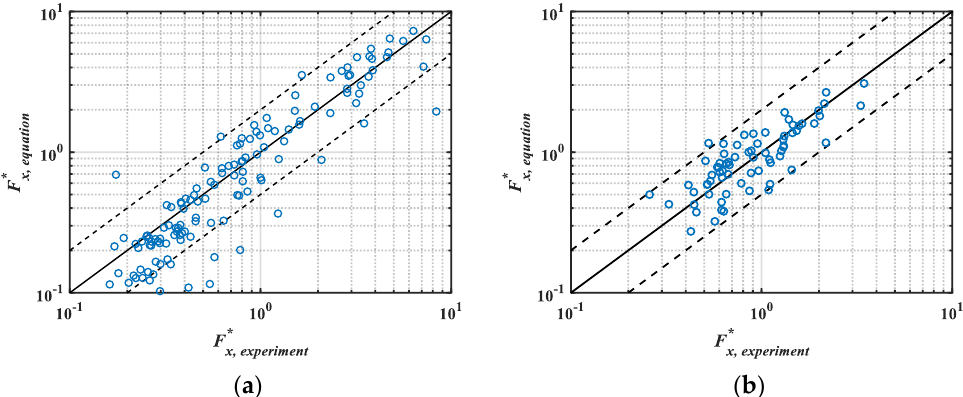
25 of 31 Table 3. Empirical coefficients for predicting the wave force on the seawall.